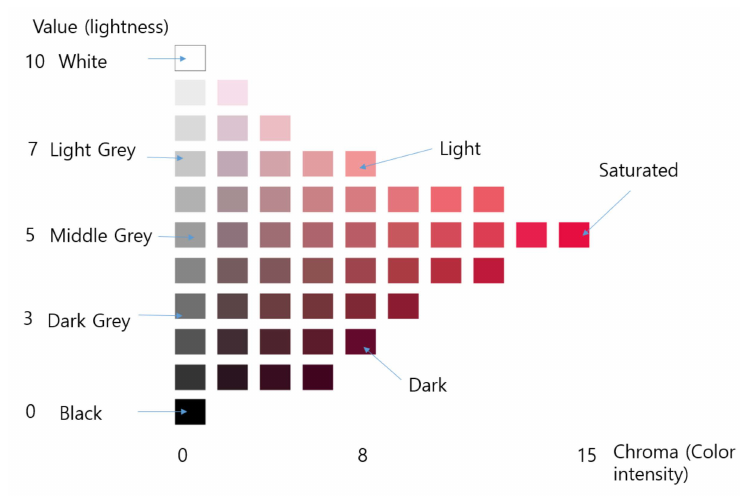
Figure 2. Saturated (S), light (L), and dark (D) for red in